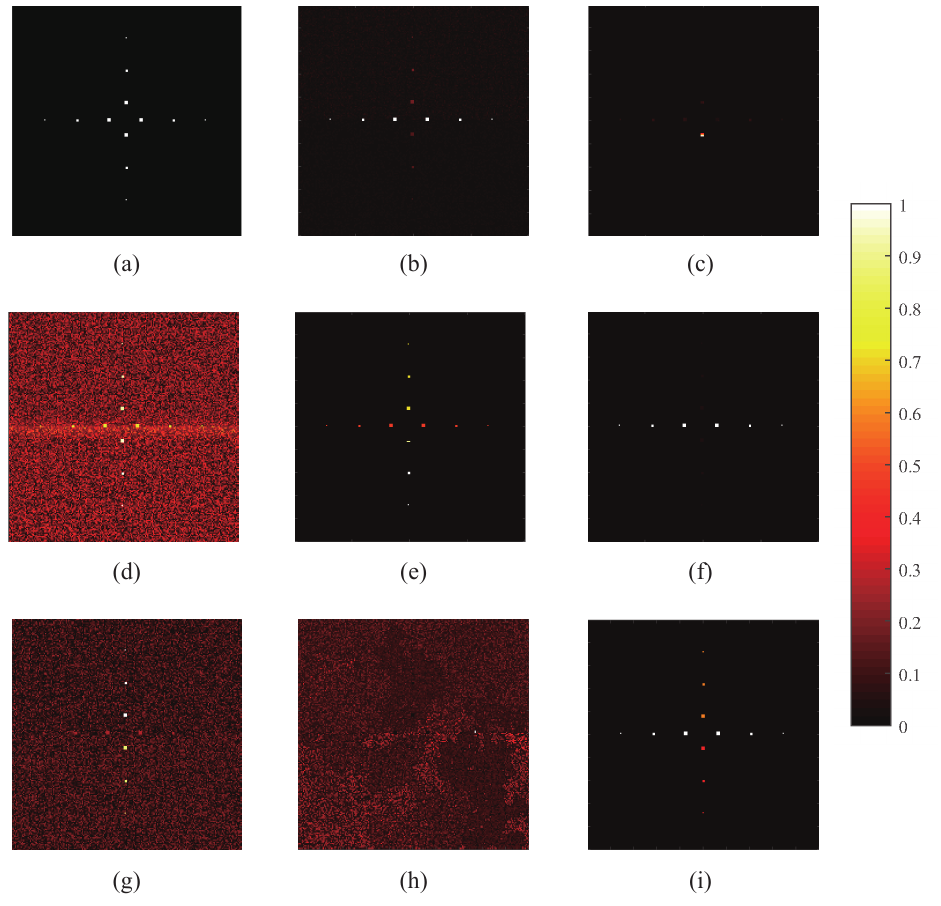
Figure 3. The detection maps of different algorithms for the simulated dataset, and the parameters in brackets are sizes of double-window used in corresponding algorithms. ( a ) Reference map. ( b )